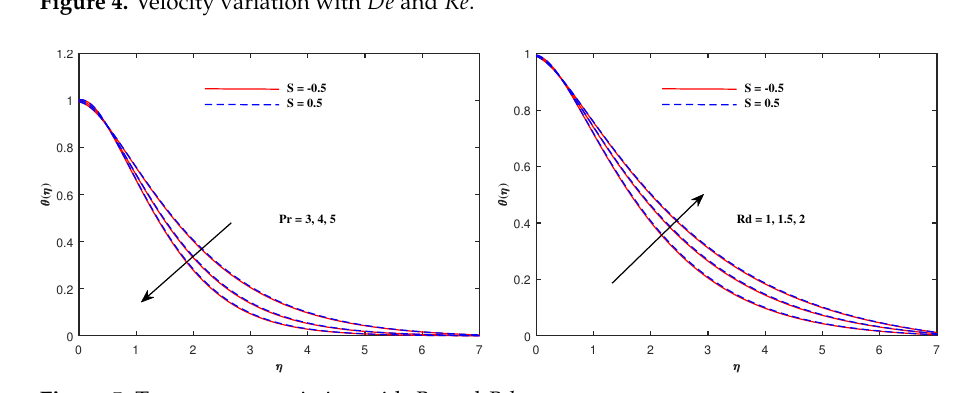
Figure 5. Temperature variation with Pr and Rd .